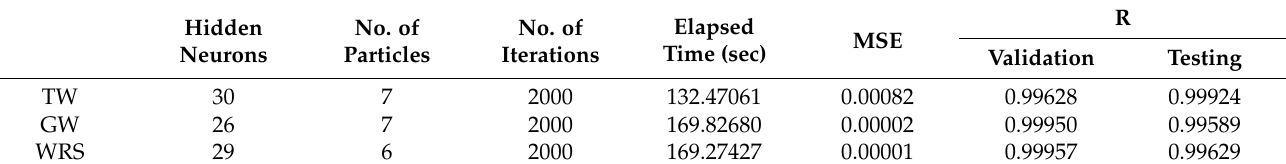
Table 15. NN-PSO simulation results for the TCR (adult) mapping of domestic water samples.